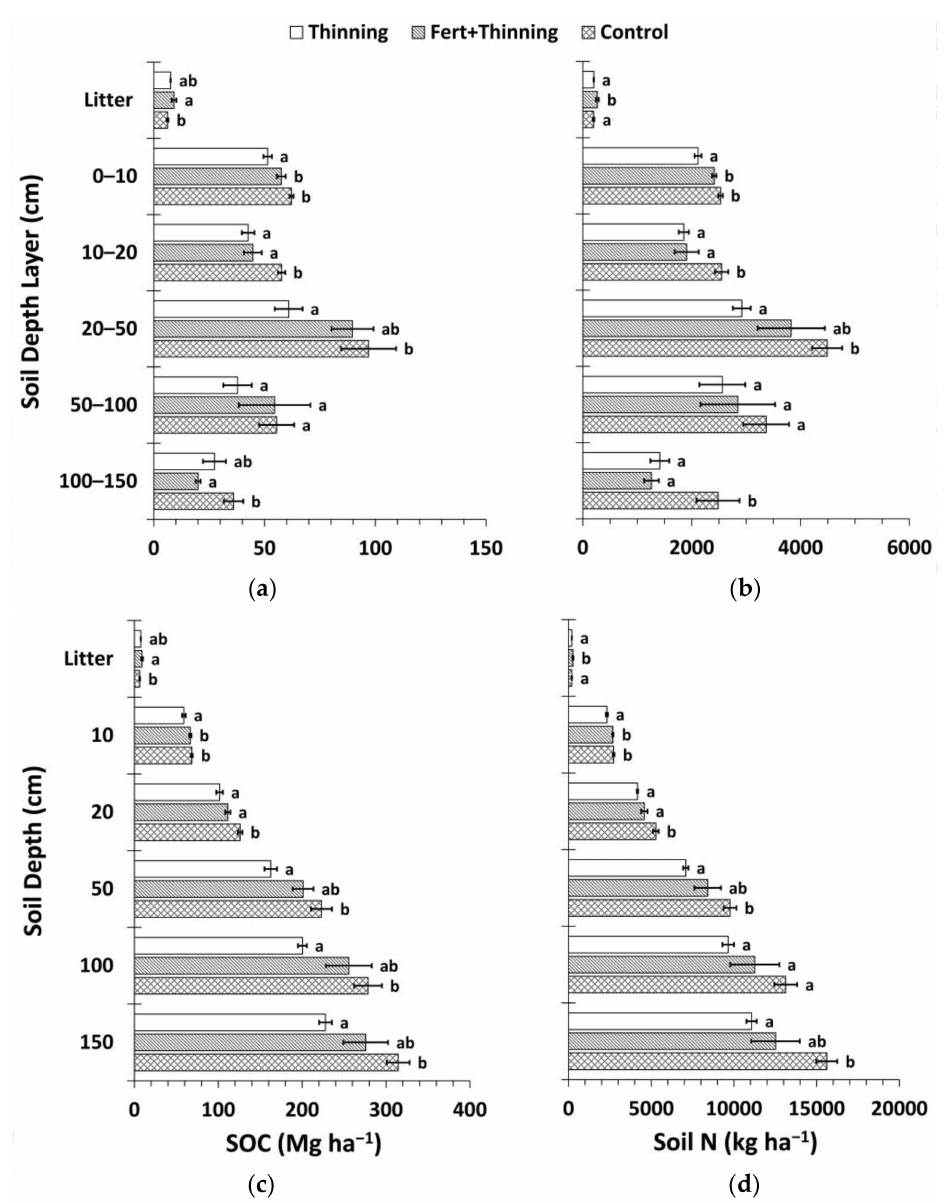
Figure 7. Mean soil organic carbon (SOC) and nitrogen (N) stocks by treatment calculated using the fixed-depth approach (Equations (2) and (3)). ( a ) Mean SOC stock by soil depth layer; ( b ) mean soil N stock by soil depth layer; ( c ) cumulative mean SOC stock; ( d ) cumulative mean soil N stock. Sample size for all treatments and soil depth layers is three. Error bars represent ± one standard error. Means within each soil depth layer accompanied by the same letter (i.e., “a” or “b”) are not significantly different (Tukey’s HSD, α = 0.1). Fert,